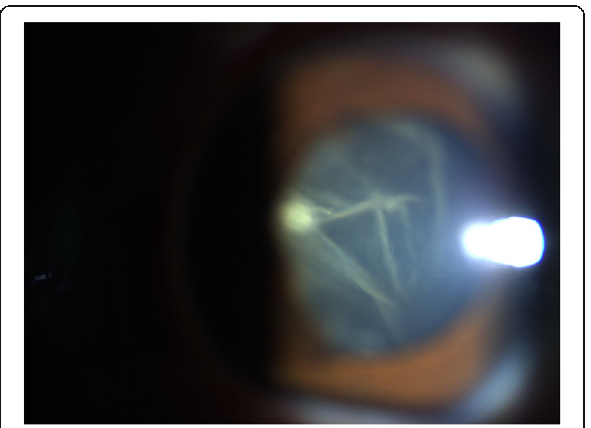
Fig. 12 Day 75 post-laser anterior segment slit lamp photograph demonstrating flapping retrolental membranes viewed while on downgaze, with accompanying uncorrected visual acuity of